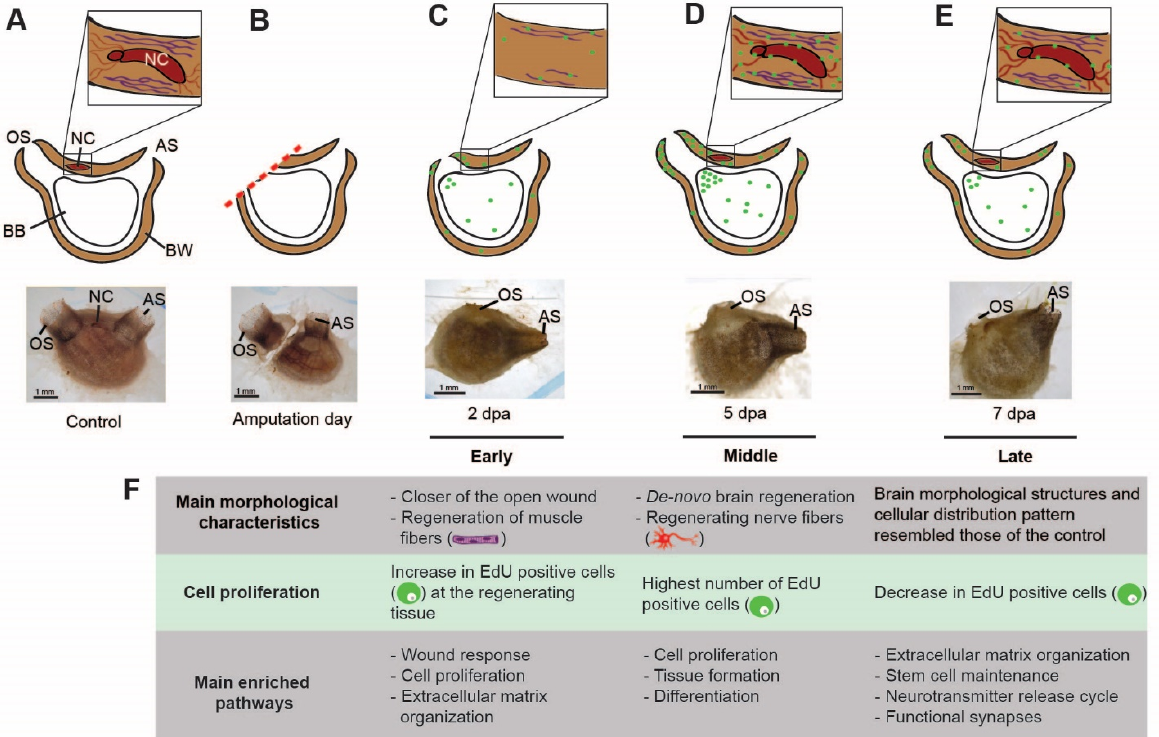
Figure 5. The cellular and transcriptome blueprint of CNS regeneration. ( A – E ) Summary of the main cellular events leading to CNS regeneration (green—EdU positive cell, red—nerve fibers, and purple—muscle fibers). ( A ) Illustration and in vivo image showing a control (pre-amputation) animal. The cerebral ganglion (CG) is embedded in the body wall (BW). Nerve fibers connecting the brain with the surrounding tissue. Muscle fibers embedded in the body wall, surrounding the brain. Atrial siphon (AS), branchial basket (BB), and oral siphon (OS). ( B ) Illustration and in vivo image showing an animal immediately following amputation. ( C ) Illustration and in vivo image showing an animal at early stage of regeneration (2 dpa). The open wound is closed by epidermal tissue composed of newly regenerating muscle fibers. The brain and associated nerves are absent. Higher levels of EdU positive cell embedded in the regenerating tissue in comparison to non-regenerating tissue. ( D ) Illustration and in vivo image showing an animal at middle stage of regeneration (5 dpa). The open wound is closed by epidermal tissue composed of regenerating muscle fibers. Nerves fibers appear at this stage and are connected to the regenerated brain. At this point we see the highest level of EdU positive cells embedded in the regenerating tissue. ( E ) Illustration and in vivo image showing animal at the late regeneration stage (7 dpa). At this point we see a decrease in the level of EdU-positive cells embedded in the regenerating tissue, albeit still higher than the level found in non-regenerating tissue. ( F ) Summary of the main morphological and molecular processes involved in CNS regeneration.